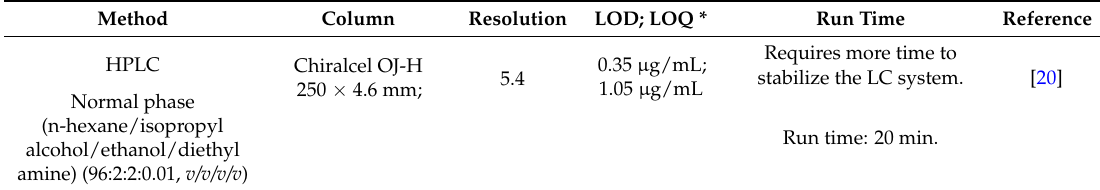
Table 1. Comparison of the proposed method with reported methods for the separation of rasagiline enantiomers.